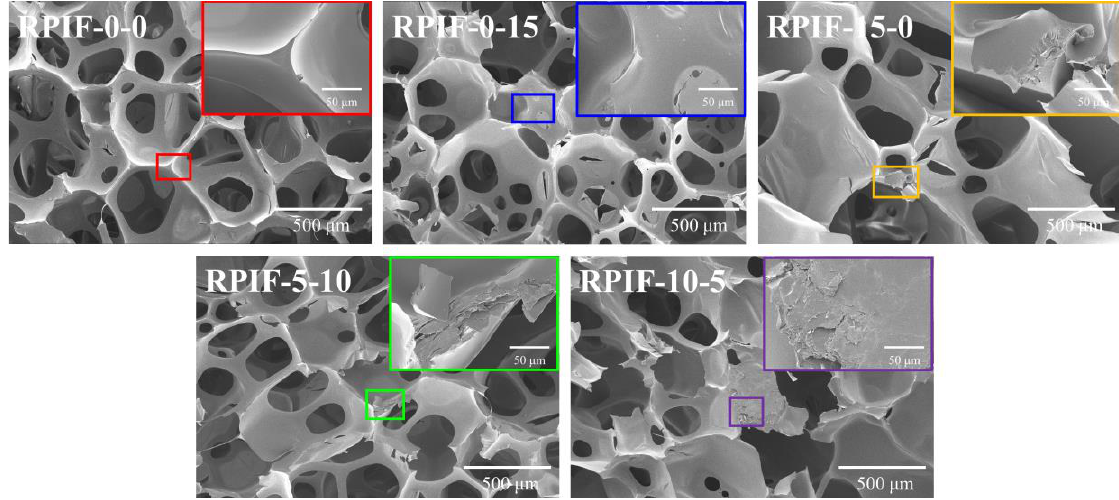
Figure 2. SEM images of partial RPIF.